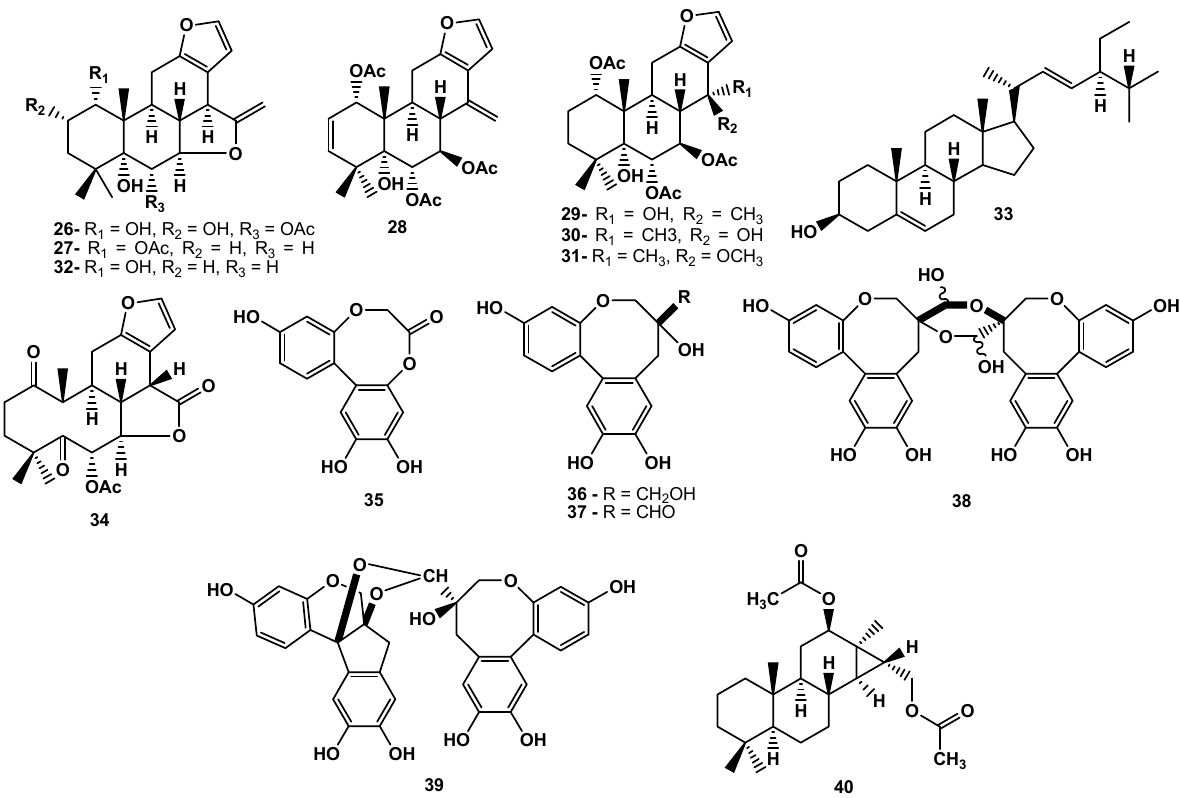
Figure 3. Triterpenoids and protosappanins isolated from species of Caesalpinia that exhibited a large spectrum of biological properties, including antiviral and antiinflammatory